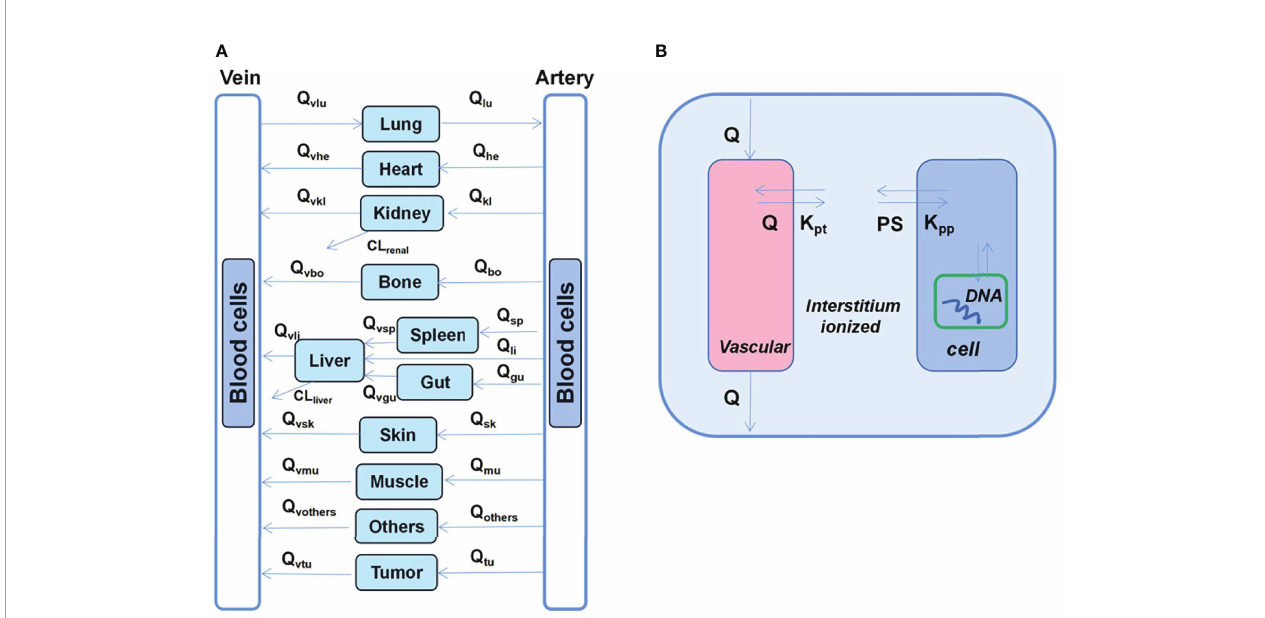
FIGURE 4 | Schematic diagram of the developed multiscale PB-PK model for doxorubicin. (A) Whole-body PB-PK model comprising seven tissues and two blood compartments. The blood compartments are further divided into plasma and blood cell sub-compartments. (B) Tissue model; each tissue is divided into the vascular, interstitial, intracellular, and nucleus DNA-bound